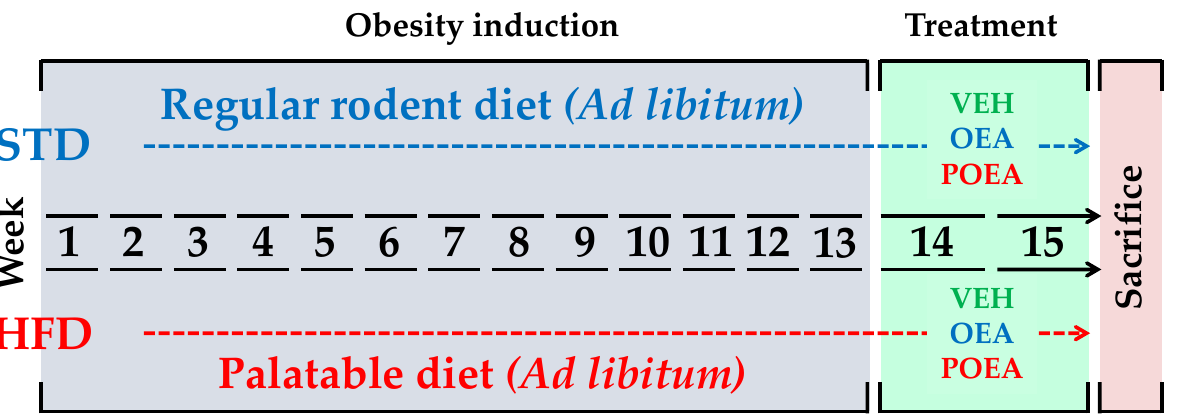
Figure 2. Experimental design. Animals exposed to either regular standard diet chow (STD) or a hypercaloric cafeteria diet (HFD) for 13 weeks were subsequently treated for two weeks with either vehicle (VEH), N-oleylethanolamine (OEA) and N-palmitoleoylethanolamine (POEA).